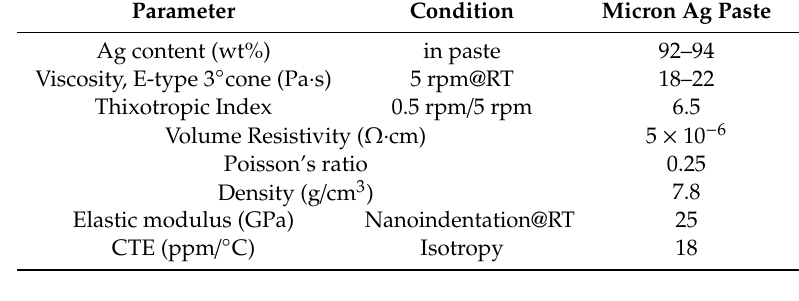
Table 1. Parameters of the pressureless sintered micron silver material.